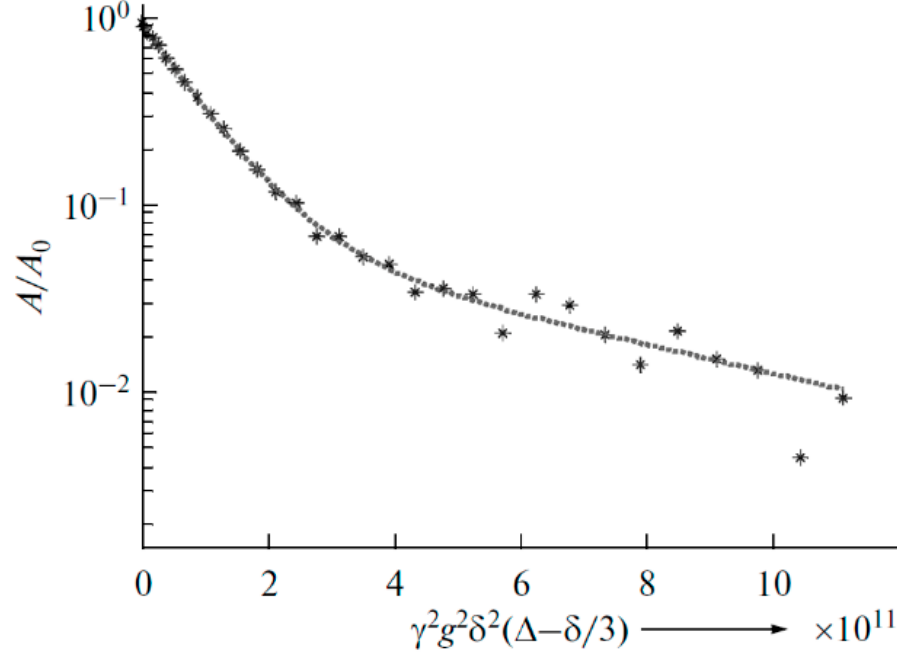
Figure 31. Diffusion decay of 7 Li for polymer electrolyte no. 2 with TiO 2 nanoparticles (10 wt %) [92].